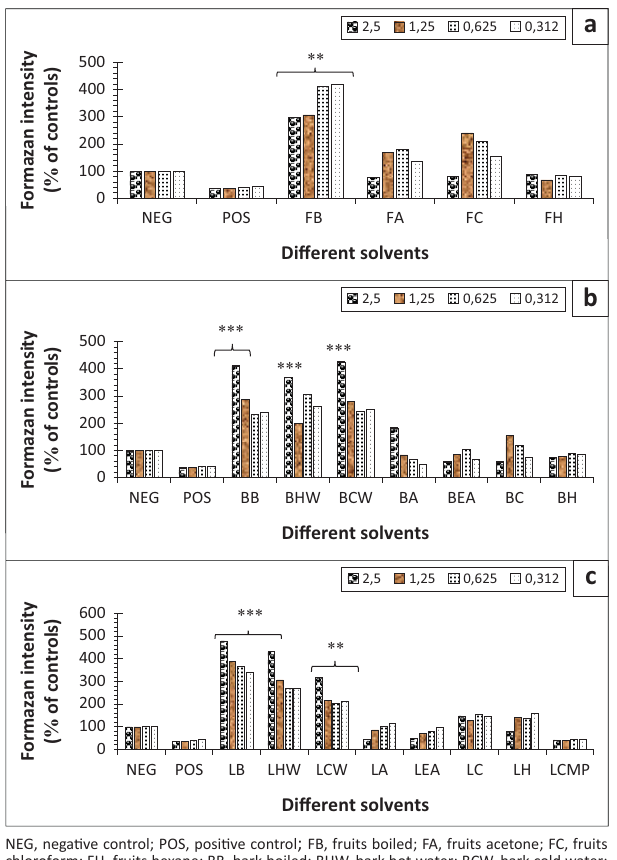
O (50 % ) as a positive 2 2